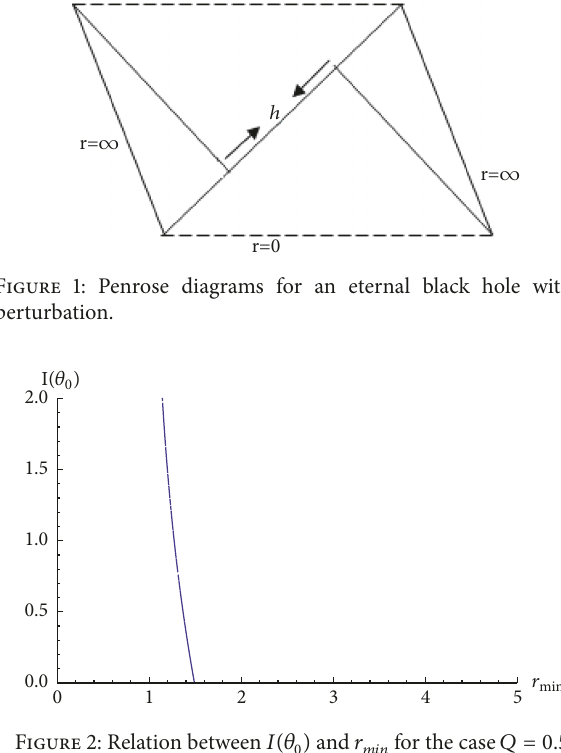
Figure 2: Relation between 𝐼(𝜃 0 ) and 𝑟 𝑚𝑖𝑛 for the case 𝑄 = 0.5 .